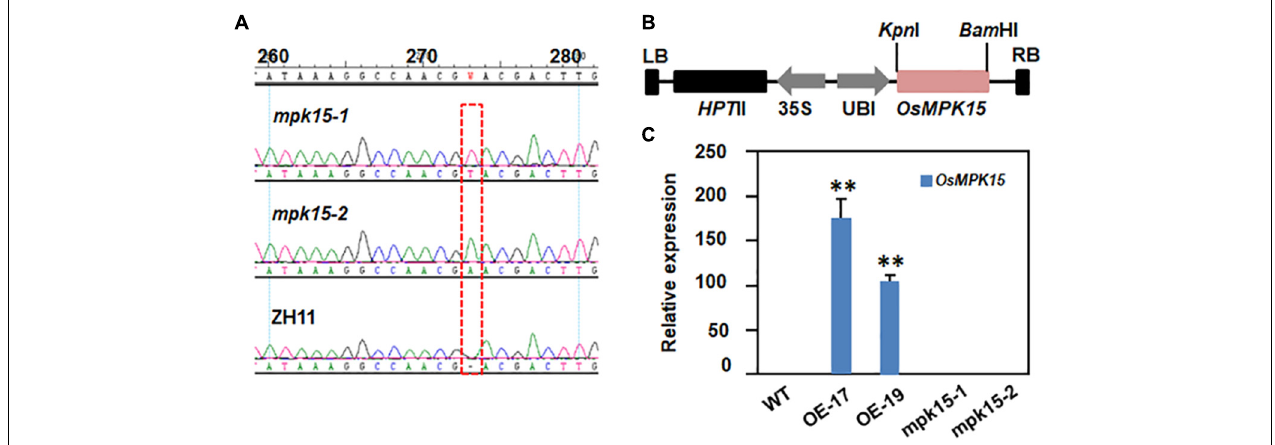
FIGURE 1 | Generation of Crispr/Cas9 edited mpk15 mutant and OsMPK15-OE lines. (A) Sequence confirmation of the homogenous mpk15-1 and mpk15-2 mutant lines., (B) Schematic diagram of the overexpression construct for rice transformation. HPT II, Hygromycin phosphotransferase II; LB, left border; RB, right border; Ubi, maize ubiquitin promoter; 35S, CaMV 35S promoter. (C) OsMPK15 expression levels in the WT, mpk15 mutant, and OsMPK15-OE lines at 30-days-old seedling. Data presented are the means ± SD from three independent experiments. ∗ P ≤ 0.05; ∗∗ P ≤ 0.01 (Student’s t -test).